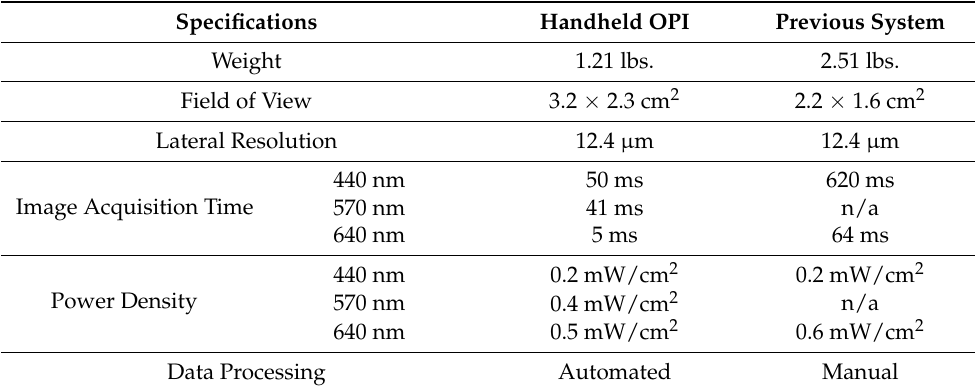
Table 1. Comparison of handheld OPI with previous imaging system. Specifications Handheld OPI Previous System